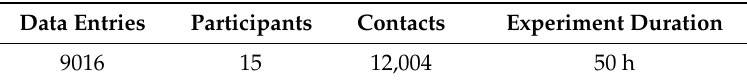
Table 1. OppNet datasets.